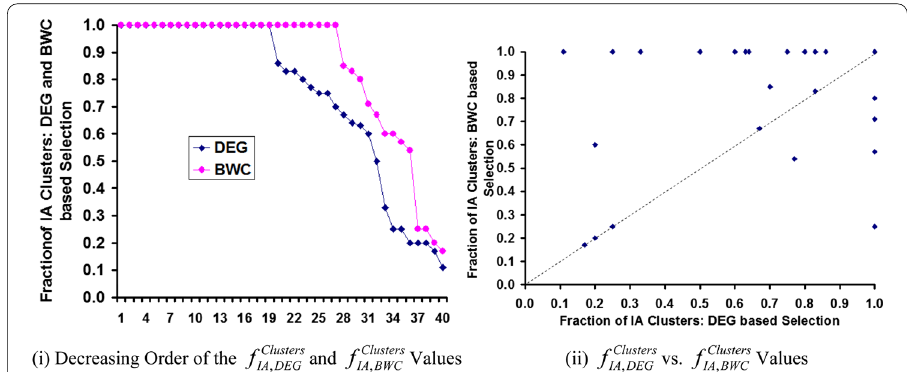
Fig. 9 Distribution of the f Clusters IA , DEG and f Clusters IA , BWC values for the real-world networks